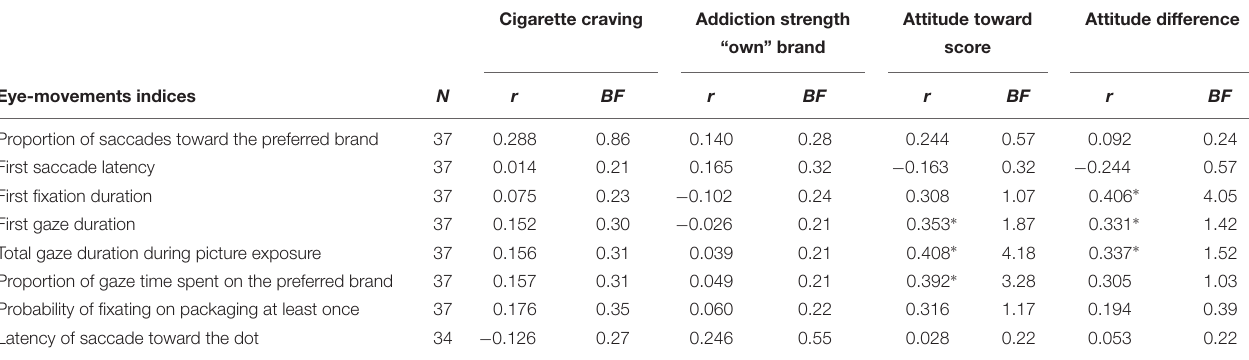
TABLE 3 | Correlations between eye-movement indices, cigarette craving, addiction strength, and attitude measures. Cigarette craving Addiction strength Attitude toward Attitude difference “own” brand score Eye-movements indices N r BF